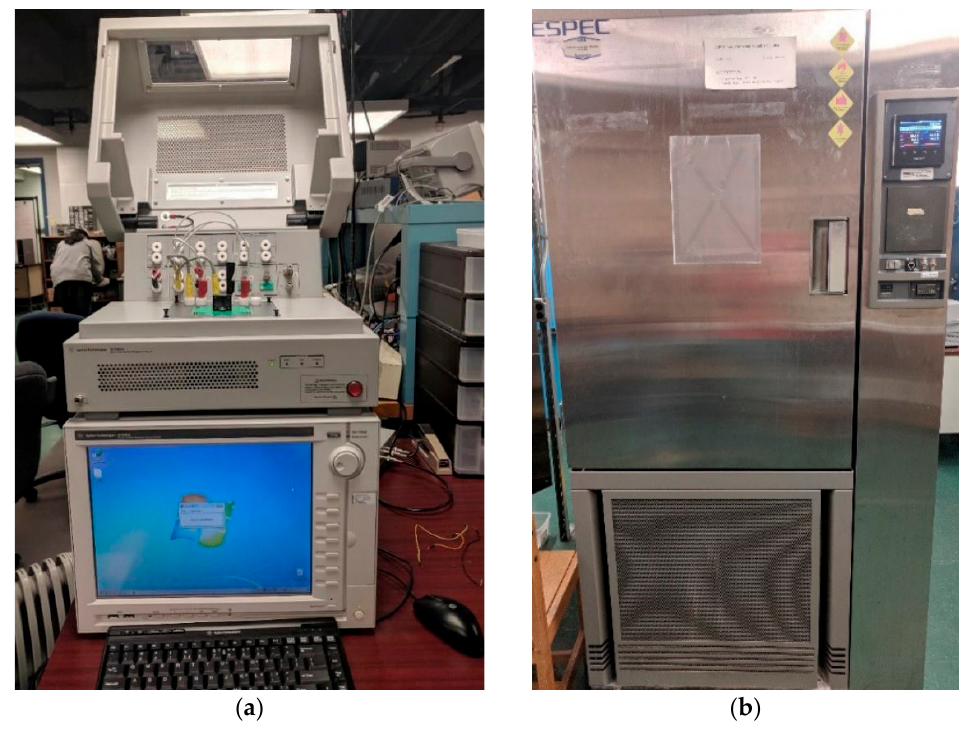
Figure 3. The Battery testing equipment. ( a ) Arbin BT2000 battery test system. ( b ) PRA-3AP temperature and humidity chamber. Table 1. Basic parameters of INR 18650-20R.